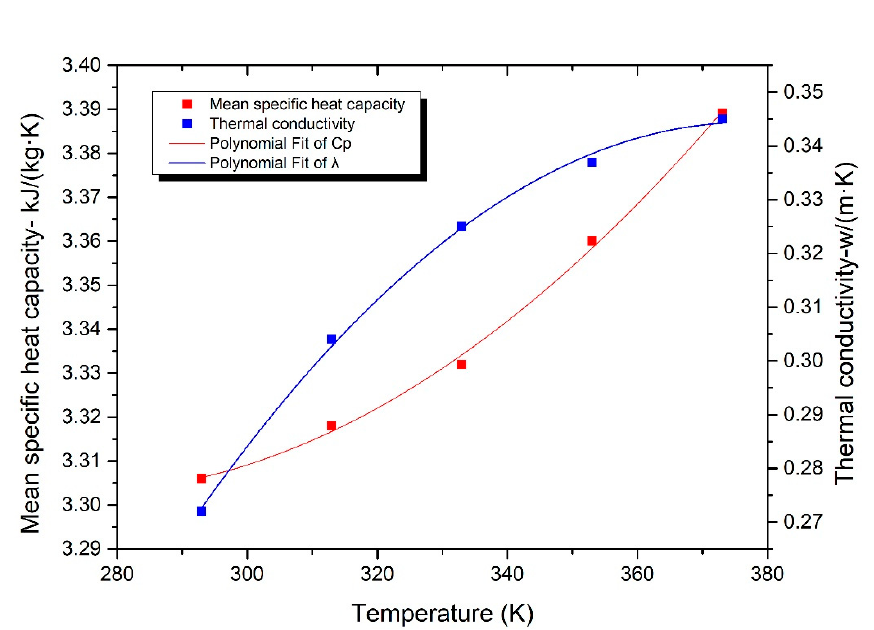
Figure 3. Relationship between temperature and specific heat capacity or thermal conductivity.